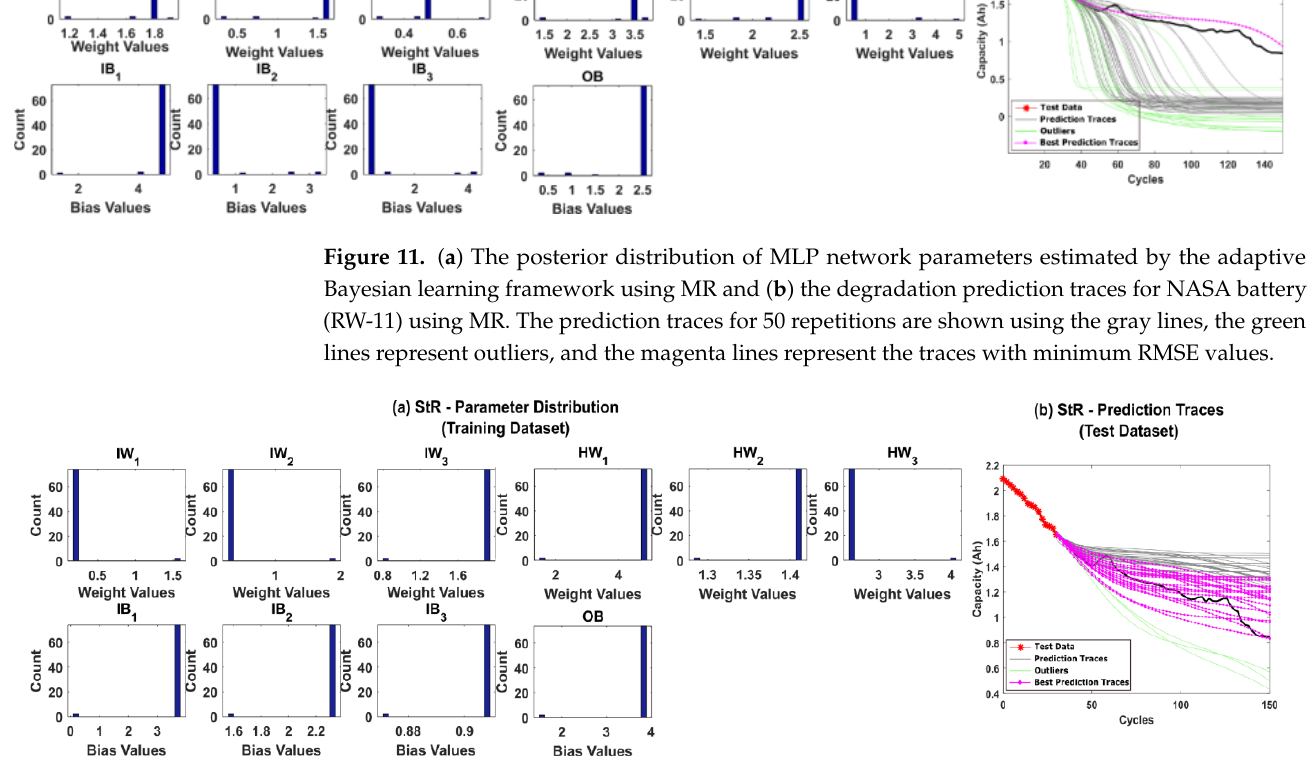
Figure 12. ( a ) The posterior distribution of MLP network parameters estimated by the adaptive Bayesian learning framework using StR and ( b ) the degradation prediction traces for NASA battery (RW-11) using StR. The prediction traces for 50 repetitions are shown using the gray lines, the green lines represent outliers, and the magenta lines represent the traces with minimum RMSE values.